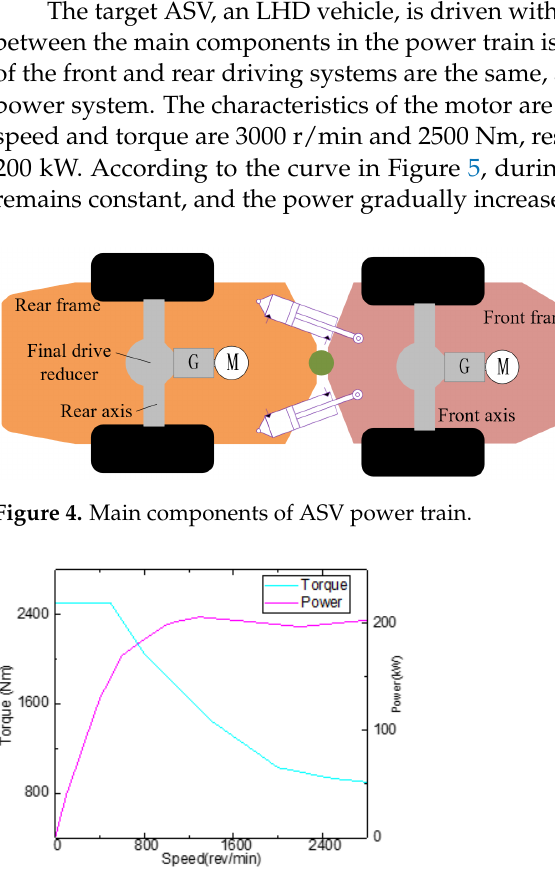
Figure 5. External characteristics of driven motor.